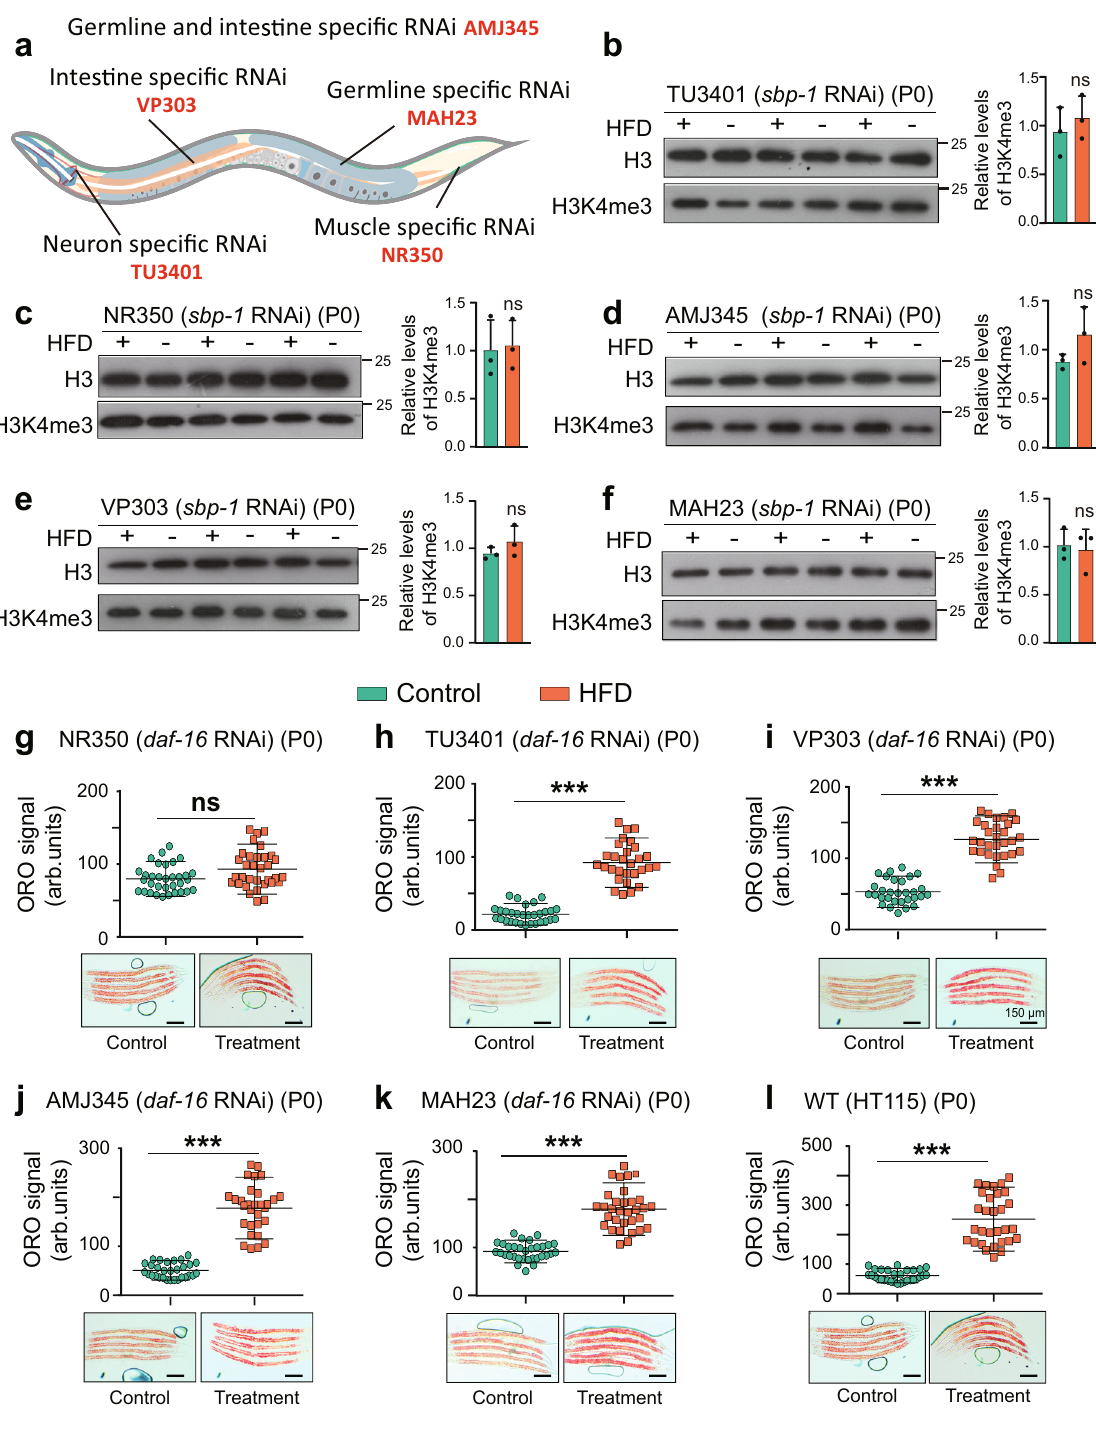
Fig. 5 Tissue-speci fi c RNAi of daf-16 or sbp-1 . a Strains used for the tissue-speci fi c gene knockdown. b – f Western blots (left panels) and quanti fi cation (right panels) of histone H3K4me3 modi fi cation in worms subjected to neuron-speci fi c sbp-1 RNAi ( b ), muscle-speci fi c sbp-1 RNAi ( c ), germline and intestine-speci fi c sbp-1 RNAi ( d ), intestine-speci fi c sbp-1 RNAi ( e ), germline-speci fi c sbp-1 RNAi ( f ) (mean ± SD; n = 3 biologically independent samples; unpaired two-tailed Student ’ s t -test; ns, not signi fi cant). g – l quanti fi cation of ORO staining in animals subjected to muscle-speci fi c daf-16 RNAi ( n ≥ 31 per condition) ( g ), neuron-speci fi c daf-16 RNAi ( n ≥ 30 per condition) ( h ), intestine-speci fi c daf-16 RNAi ( n ≥ 30 per condition) ( i ), germline and intestine- speci fi c daf-16 RNAi ( n ≥ 30 per condition) ( j ), germline-speci fi c daf-16 RNAi ( n ≥ 31 per condition) ( k ) and without any RNAi exposure ( n ≥ 30 per condition) ( l ). For g – l , graph data are presented mean ± SD; unpaired two-tailed Student ’ s t -test; *** p < 0.001, ns: no signi fi cance; scale bar = 150 μ m. Source data are provided as a Source Data fi le.